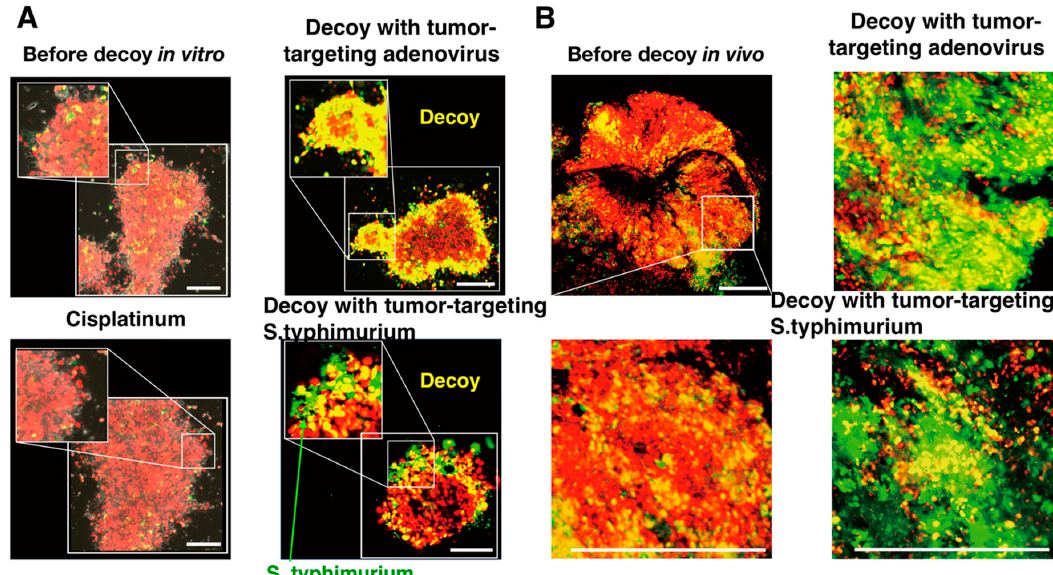
Figure 9. Cell-cycle decoy of tumor-targeting adenovirus and tumor-targeting Salmonella typhimurium A1-R, observed with FUCCI imaging. ( A ) Representative images of the decoy of quiescent cancer cells in vitro, before and after decoy. Tumor-targeting adenovirus and tumor targeting S. typhimurium A1-R decoy quiescent cancer cells in tumor spheres from G1 into early-S and late-S / G 2 phases (right). ( B ) Representative images of decoy of quiescent cancer cells in vivo. Tumor-targeting adenovirus and S. typhimurium decoy quiescent cancer cells in tumors in vivo into early-S and late-S / G 2 phases [22]. Scale bar; 500 µ m.